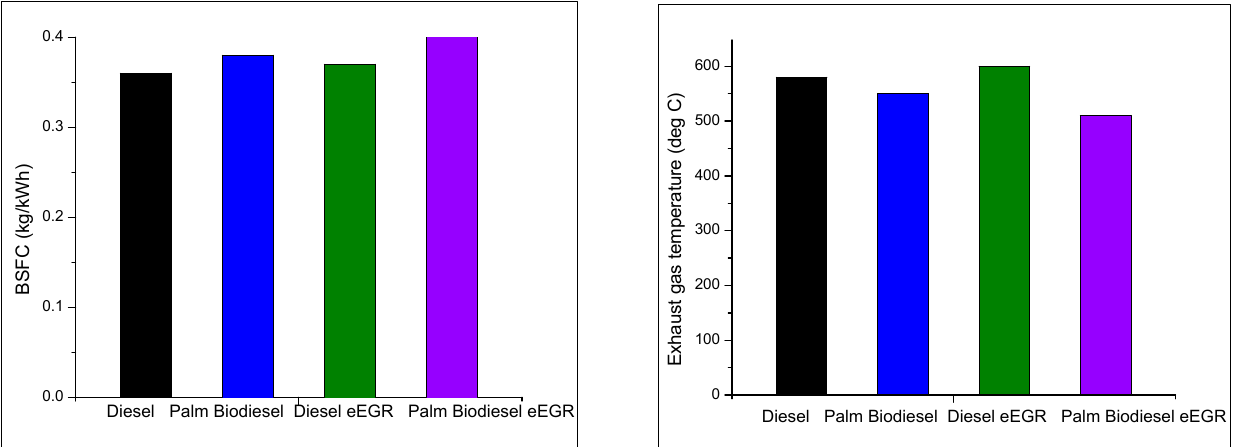
Figure 6. Effect of eEGR rate on the flame kernel growth rate. Yasin et al. [65] studied the performance of an engine fueled by palm oil biodiesel, combining an experiment with simulations to estimate the effect of eEGR at full loads and an engine speed of 2000 rpm. They found BSFC and CO emissions increased while exhaust gas temperature and NO x emissions decreased when using eEGR compared with the same engine fueled by diesel (Figures 7 and 8). The lower heat value of biodiesel fuels means the peak firing temperature and exhaust gas temperature will be lower compared with conventional diesel fuel. As a result, lower NO x emissions and higher CO emissions were reported using biodiesel fuel with eEGR .